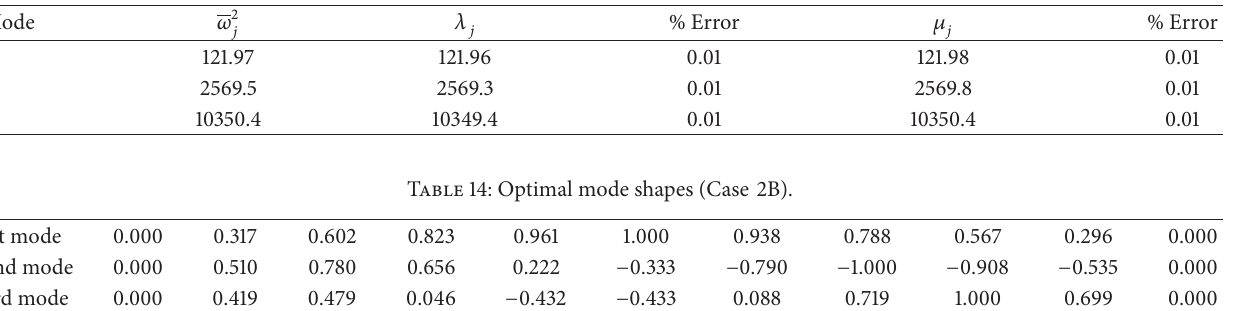
Table 13: Optimal frequencies and MRQA (Case 2B).